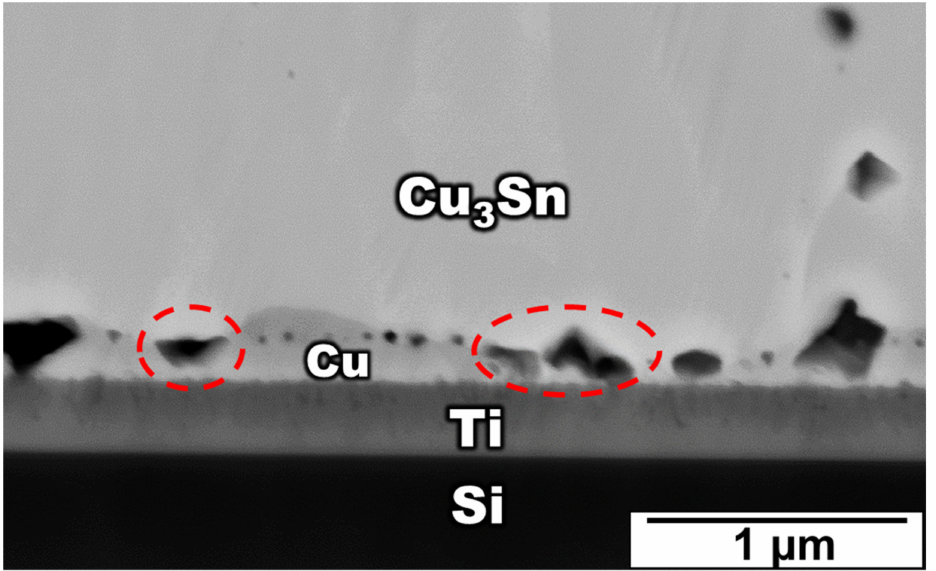
Figure 8. The zoomed-in image of voids formation and voids growth at the Cu 3 Sn/Cu interface after aging at 200 ◦ C for 36